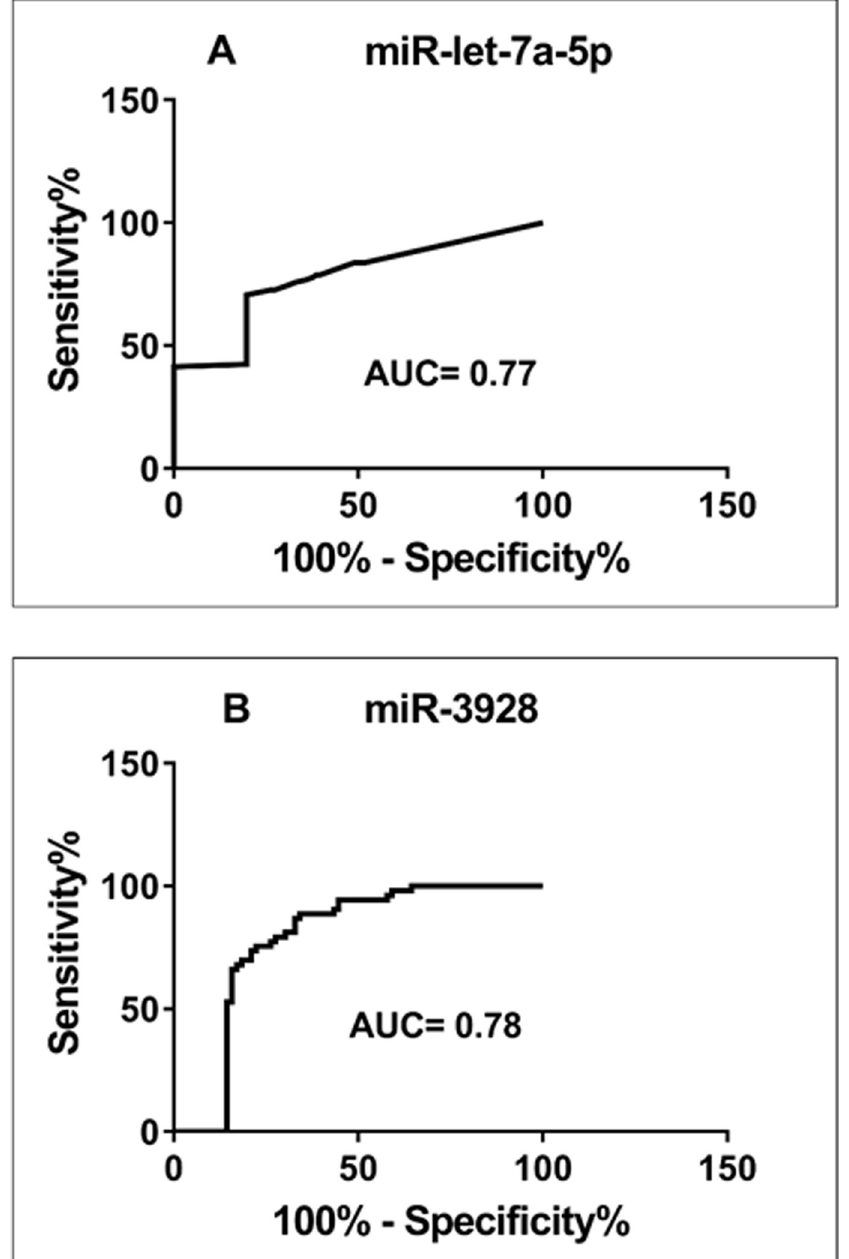
Fig 2. Receiver operator curve (ROC) analysis of the independent validation study using saliva-derived (A) miR-let- 7a-5p and (B) miR-3928.